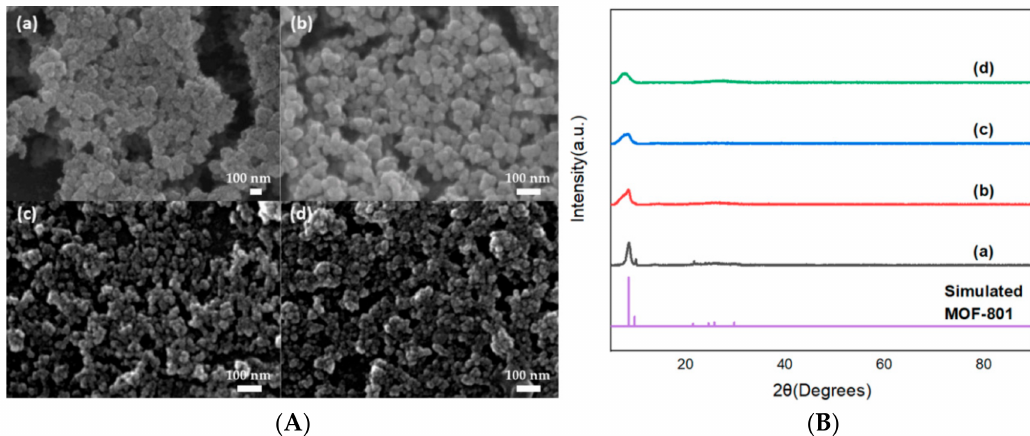
Figure 2. SEM ( A ) and XRD ( B ) diagrams of the samples prepared in ( a ) 20 mL of water, 20 mL of ethanol, with polyhedrons of approximately 100 nm; ( b ) 40 mL of water, 20 mL of ethanol, with granules of approximately 40 nm; ( c ) 60 mL of water, 20 mL of ethanol, with intergrown nanosized crystallites; ( d ) 80 mL of water, 20 mL of ethanol, with intergrown nanosized crystallites.